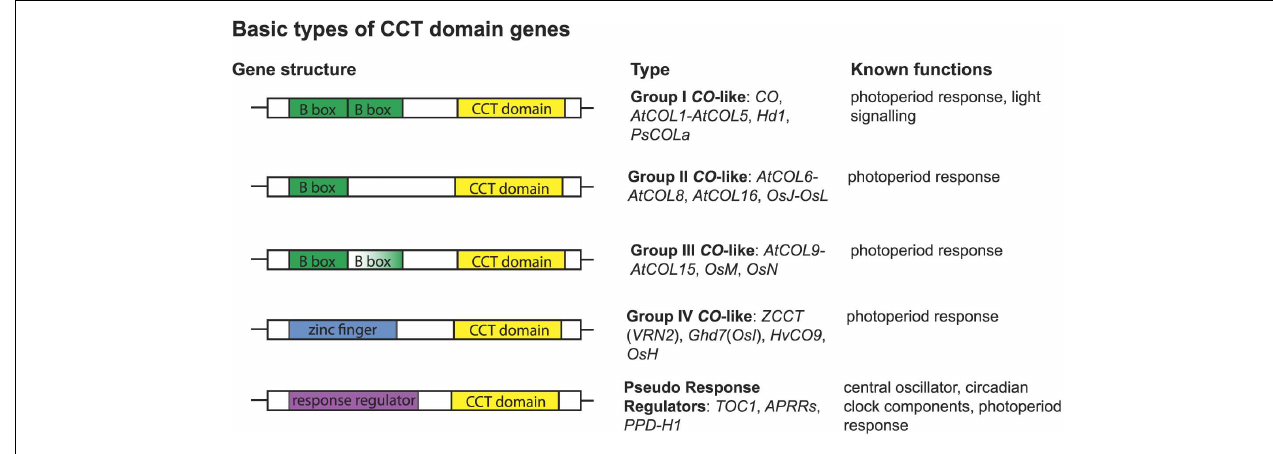
B-box zinc finger domains, however the second domain is partially degraded. Group IV genes are the least well described and have a less conserved 5 (cid:2) zinc finger somewhat representing a C 2 H 2 zinc finger.The pseudo response regulators have a 5 (cid:2) response regulator domain. For each type, characterized example loci are listed along with their known functions (see text for